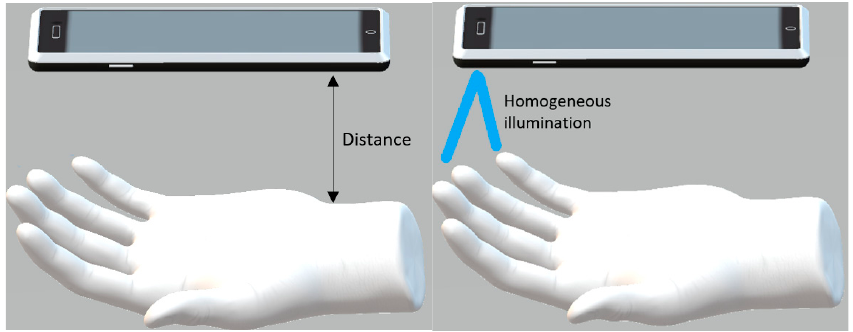
Figure 4. Homogeneous distance illumination with auto focus capturing by smartphone.